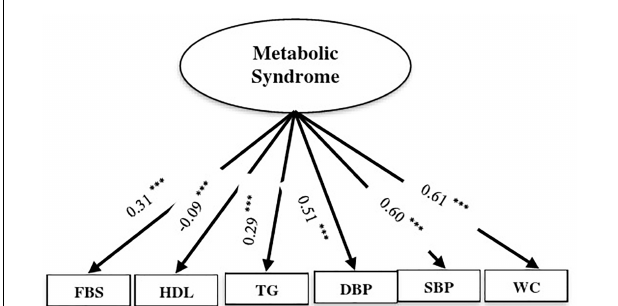
FIGURE 2 | Confirmatory factor analysis (CFA) of the measurement model of metabolic syndrome components. Ellipses represent latent variables; boxes represent observed variables. All coefficients are standardized and have a P -value < 0.001. Fit indices: CMIND/DF = 13.64, DF = 4, GFI = 0.99, AGFI = 0.97, CFI = 0.99, IFI = 0.99, SRMR = 0.02, RMSEA = 0.06 ( ∗∗∗ P < 0.001).